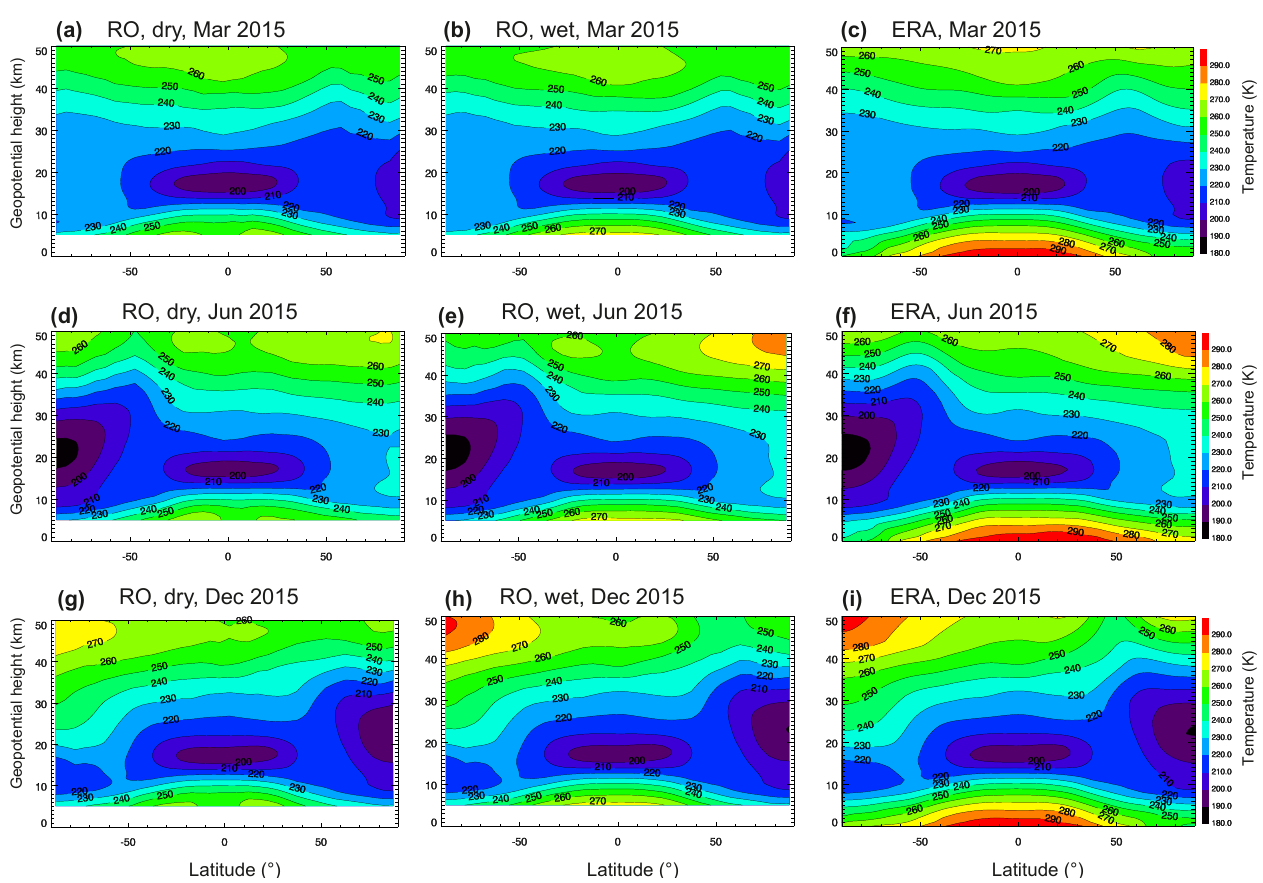
Figure 2. Zonal mean temperatures as a function of latitude and altitude for the months March, June, and December 2015 (a–i) from METOP-A and B radio occultations (a, d, g) and from ERA-Interim (c, f, i)